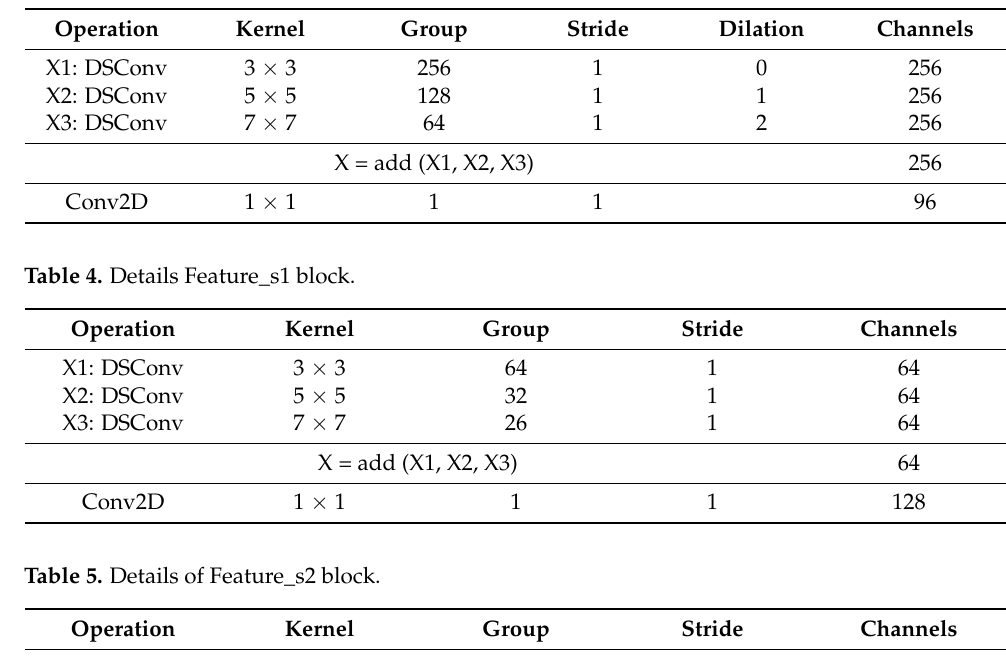
Table 3. Details of Feature_d block.